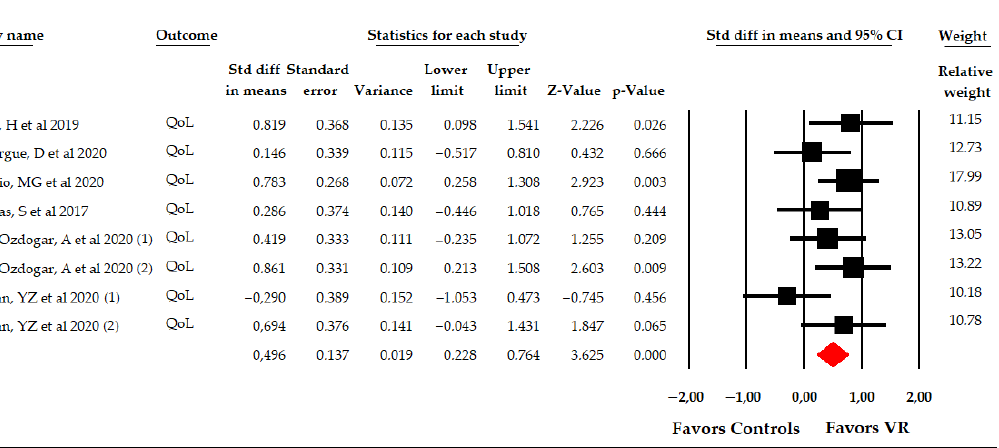
Figure 6. Forest Plot of the Effect of Virtual Reality on Overall Quality of Life.